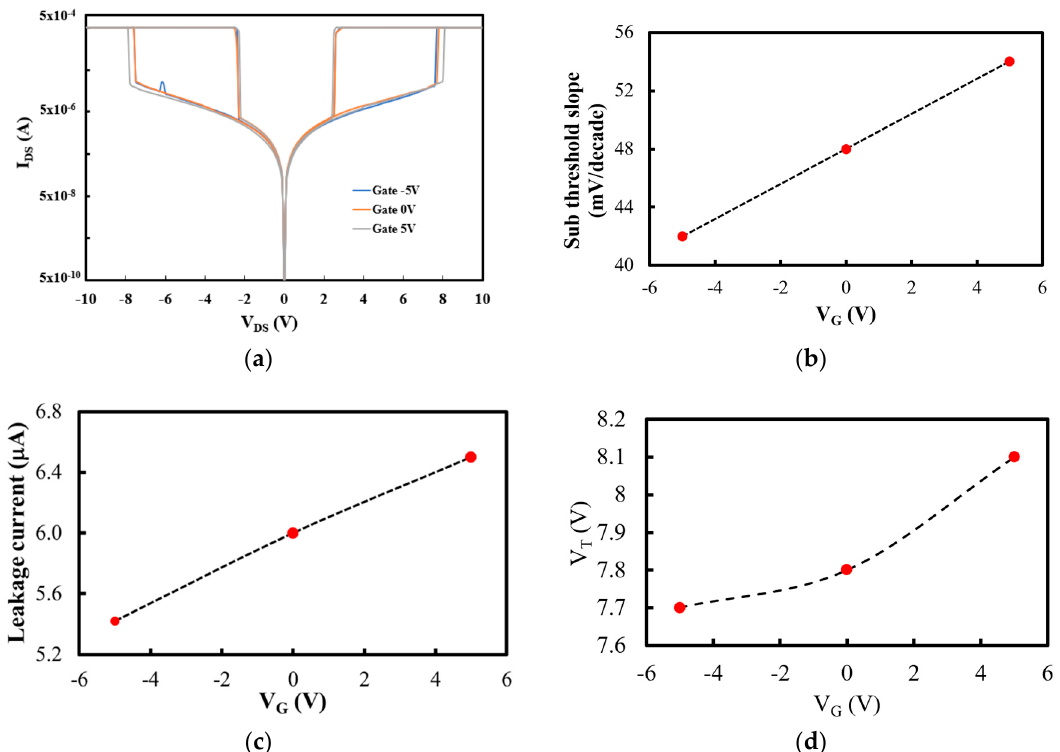
Figure 5. ( a ) NP-VO 2 MOSFET characteristics at room temperature. The current was limited to 0.5 mA, and the V DS voltage steps was 100 mV. ( b ) Sub-threshold slope (S t ) of the I DS versus V G . ( c ) Leakage current as a function of V G . ( d ) Threshold voltage as a function of gate voltage.